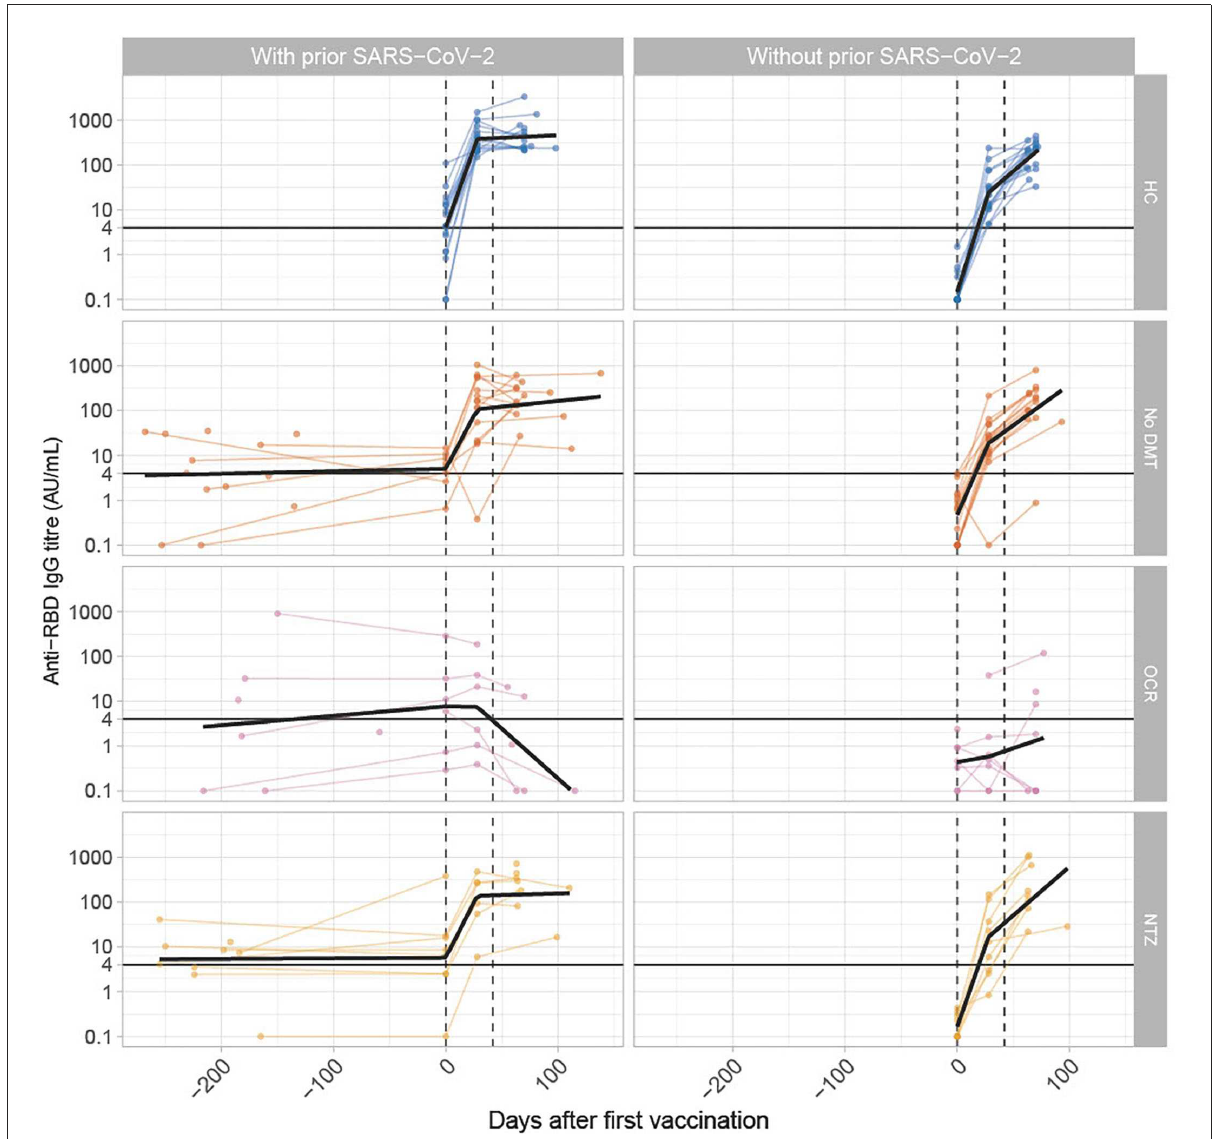
FIGURE1 Longitudinal SARS-CoV-2 antibody titers in patients with and without prior SARS-CoV-2 infection. The figure shows anti-RBD titers over time in patients with MS in various treatment groups. The x-axis shows time in days before and after the first vaccination. The y-axis is a logarithmic scale of anti-RBD-IgG titers in AU/mL. The Dots indicate antibody titers for individual participants. The black line indicates the regression line per group to demonstrate a trend. The horizontal black line indicates the cut-off for seroconversion ( > 4 AU/mL). The dotted lines, respectively, indicate the median timing of the first and second vaccination, either with mRNA vaccines (Moderna/Pfizer) or ChAdOx1 nCoV-19 (AZD1222) vaccine from Oxford-AstraZeneca. The median time between the first and second vaccination was 42